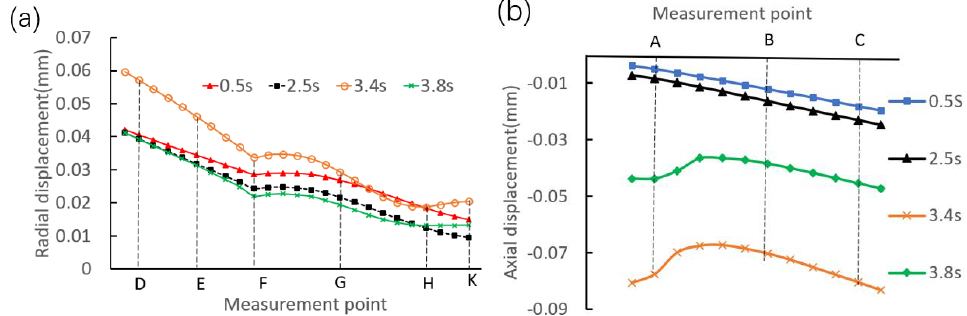
Figure 14. Displacement distributions of the inner ring at the representative moments. ( a ) Along the side generatrix. ( b ) Along the upper generatrix.